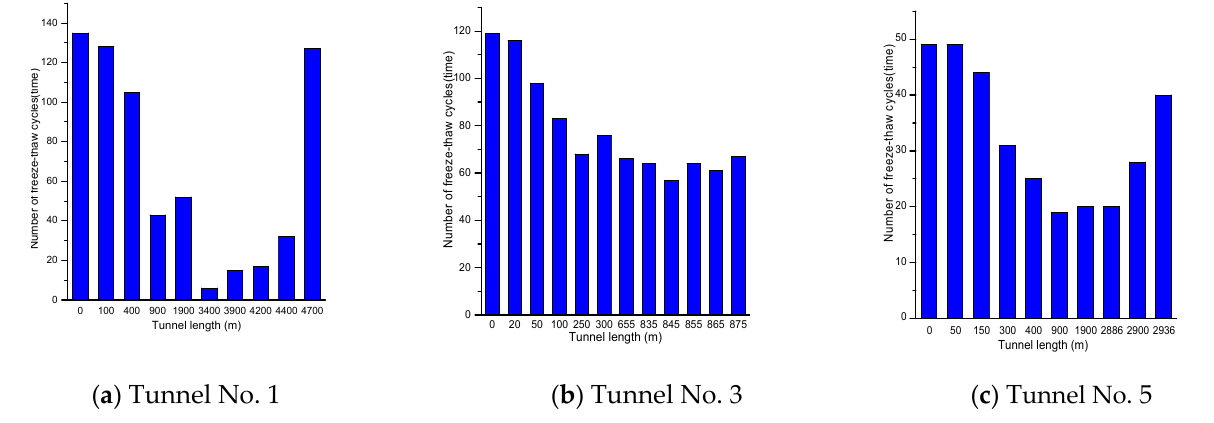
Figure 3. The number of daily freeze–thaw cycles in tunnels.